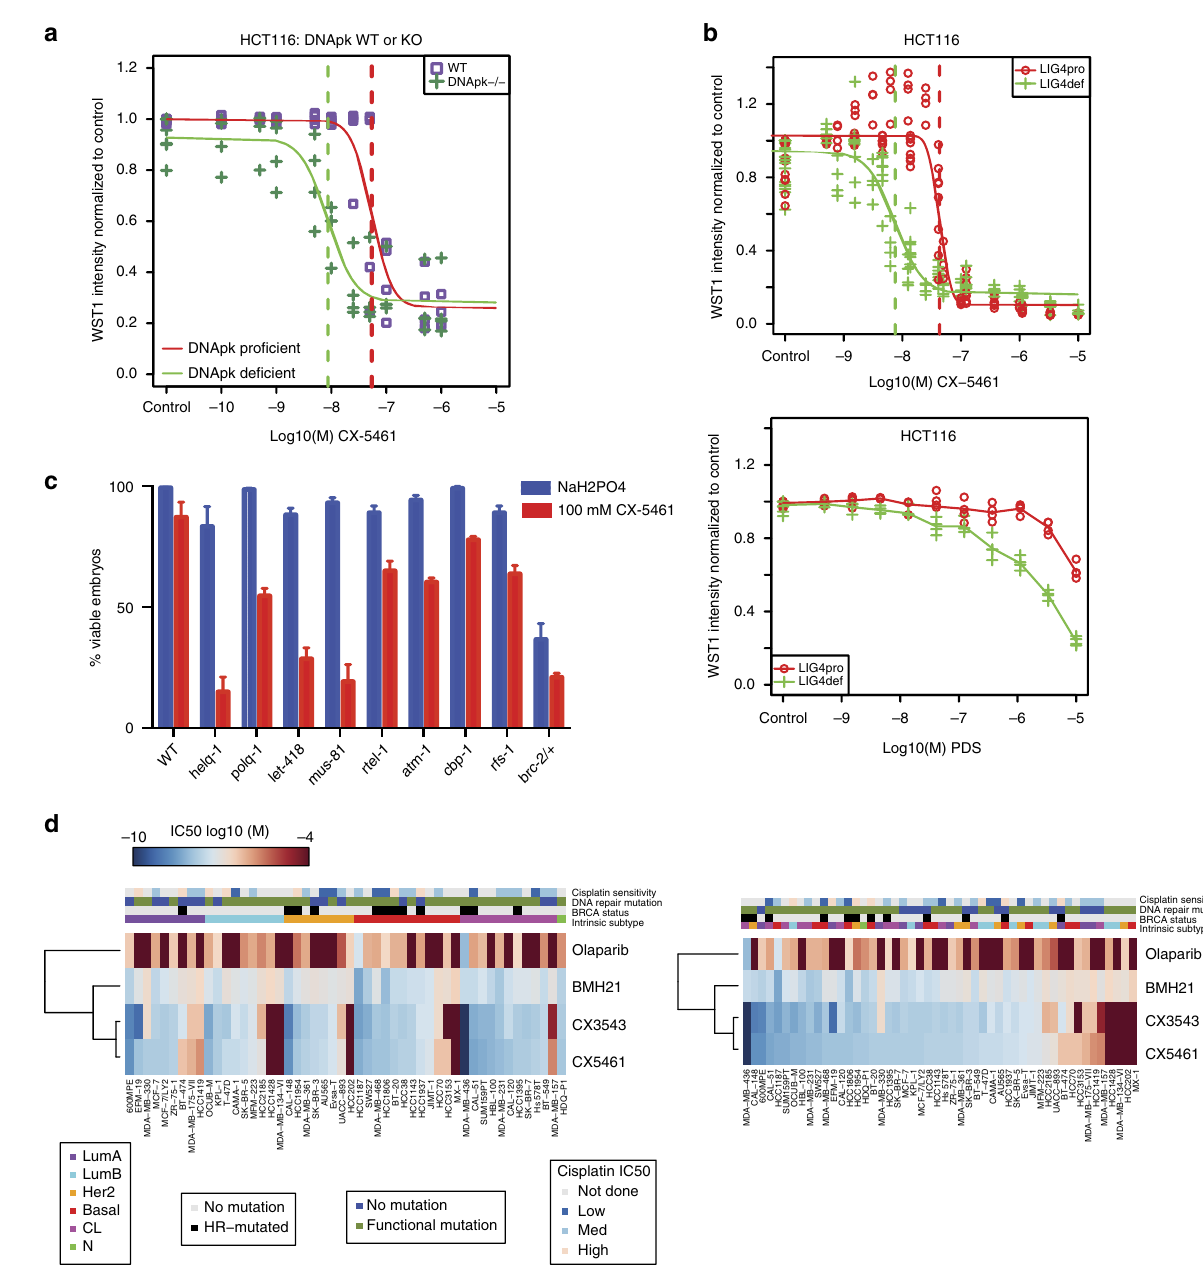
Figure 7 | CX-5461 effectively kills tumour cells deficient for a number of DNA damage repair pathways. ( a ) PRKDC (cid:2) / (cid:2) HCT116 cells are more sensitive to CX-5461 compared with PRKDC wild type HCT116 cells. The dose sensitivity of CX-5461 (6 days in drug) was measured by WST-1 assay with representative experiment #2 shown (see Supplementary Fig. 7a for all three experiments). Vertical dashed lines indicate the estimated IC50 values. ( b ) LIG4 (cid:2) / (cid:2) HCT116 cells are more sensitive to CX-5461 and PDS compared with LIG4 wild type HCT116 cells. The drug sensitivity (4 days in drug) was measured by a WST-1 assay. n Z 4. IC50 difference for CX-5461 between LIG4 þ / þ and LIG4 (cid:2) / (cid:2) cells is 5.73 ( P o 10 (cid:2) 10 , t -test). Sigmoid fits were unavailable for PDS treated cells so no IC50 estimates or fold change was available. Assessment via a two-way ANOVA test showed that Lig4 deficient cells were more sensitive to PDS than Lig4 proficient cells ( F -test P o 10 (cid:2) 10 ). Results of drug sensitivity to BMH-21 and cisplatin for LIG4 þ / þ and LIG4 (cid:2) / (cid:2) cells are shown in Supplementary Fig. 7b. ( c ) Genotype specific sensitivity to CX-5461 in C. elegans . The percentage of viable embryos observed in the progeny of animals treated for B 20h with 100 m M CX-5461 or carrier (50 m M NaH 2 PO 4 ). Error bars depict the s.e.m. of at least three experiments. Statistically significant difference by t -test was discovered for all mutants shown in this figure ( P o 0.05) comparing carrier-treated to CX-5461-treated animals. ( d ) CX-5461/CX-3543 exhibits antiproliferative potency against a panel of breast cancer cell lines by SRB cytotoxicity assay. Heatmap represents IC50 values for 50 breast cancer cell lines treated with Olaparib, BMH-21, CX-3543 and CX-5461 for 5 days. The ward-linkage method of ‘hclust’ (R function) was used to compute the dendrogram. The panel on the left is ordered by intrinsic subtype of cell lines, the panel on the right is ordered by ranked value of CX-5461 sensitivity. The legends indicate the categorical values for intrinsic subtype, BRCA mutation status, DNA repair mutation status, and cisplatin sensitivity (data from Sanger cell line